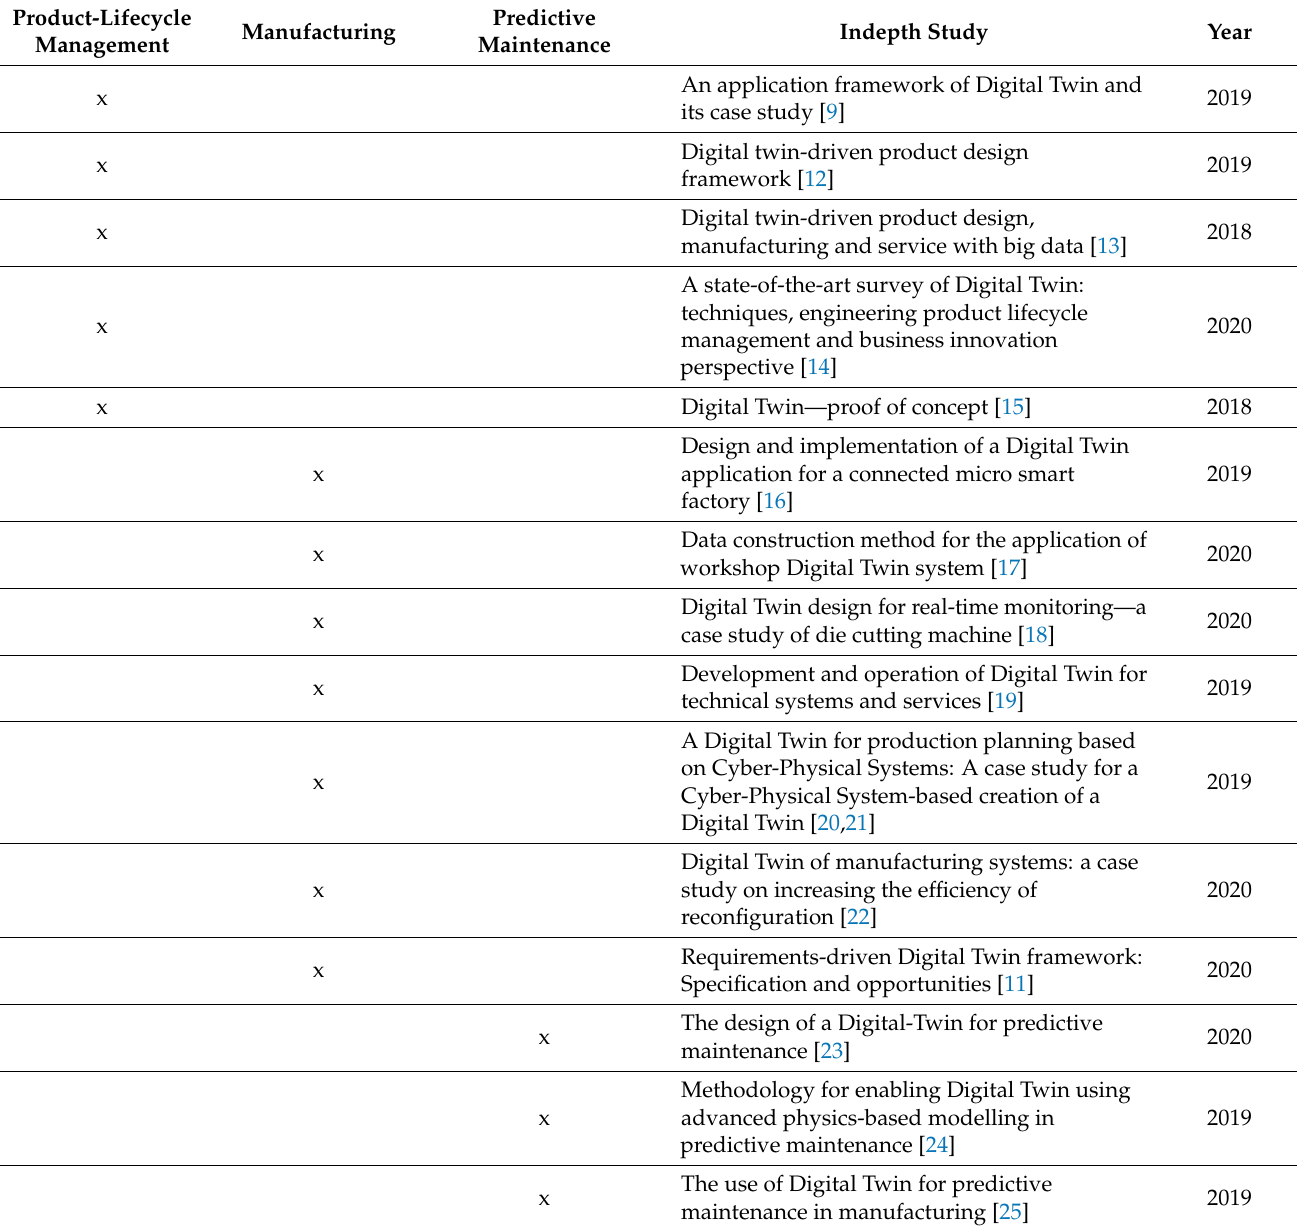
Table 2. Selected in-depth studies on the development of DTs in domain